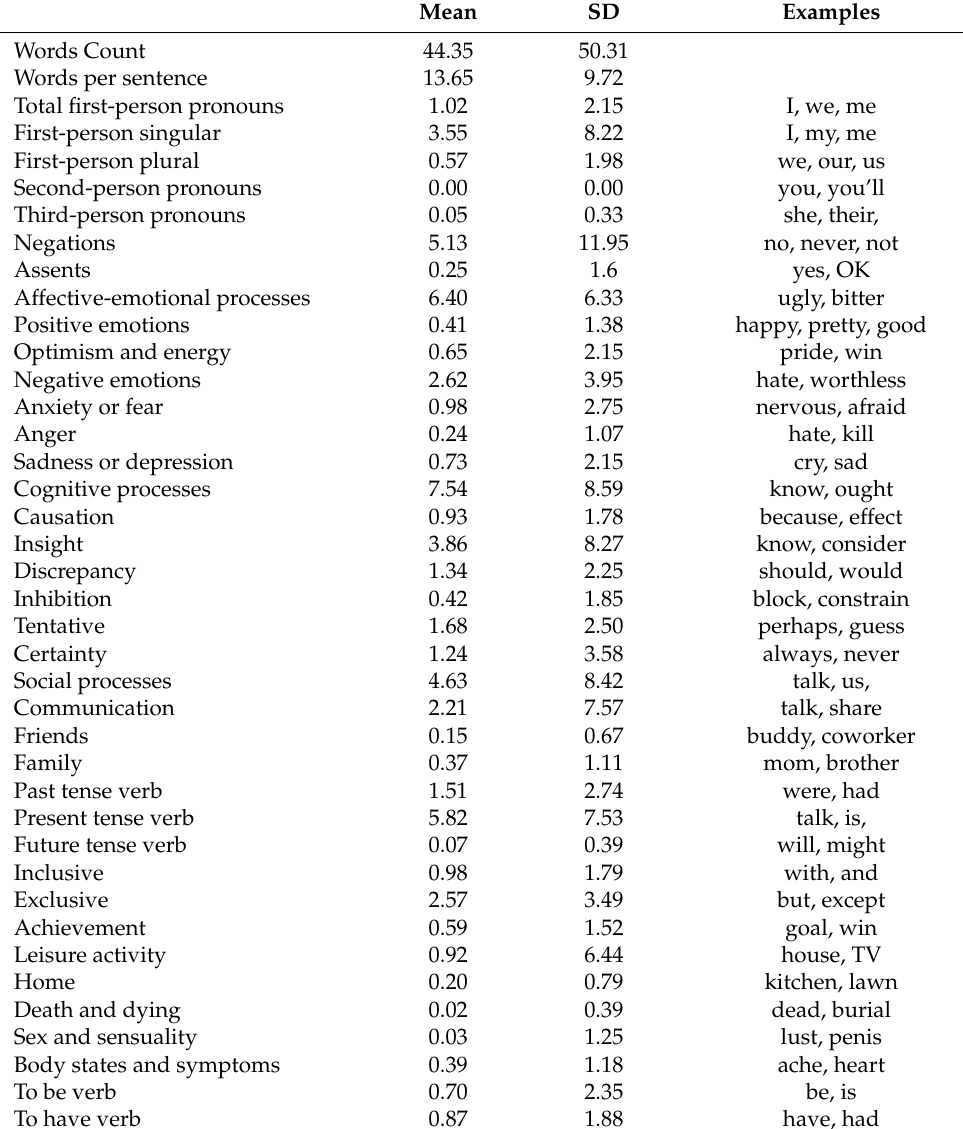
Table 2. Sample mean values of linguistic measures and dictionary